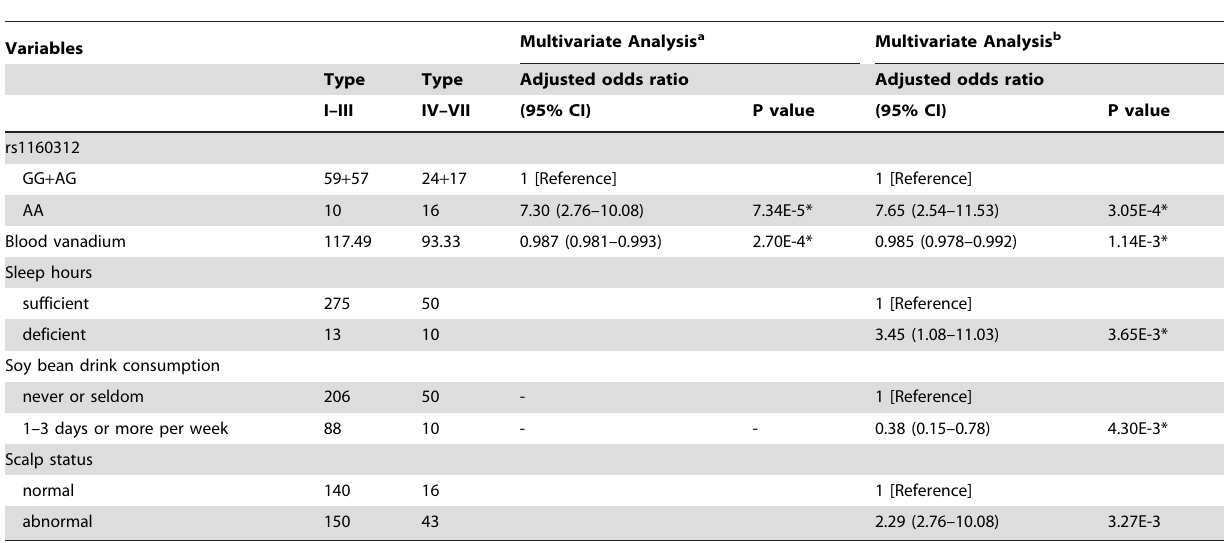
Table 5. The optimal model of male AGA and related